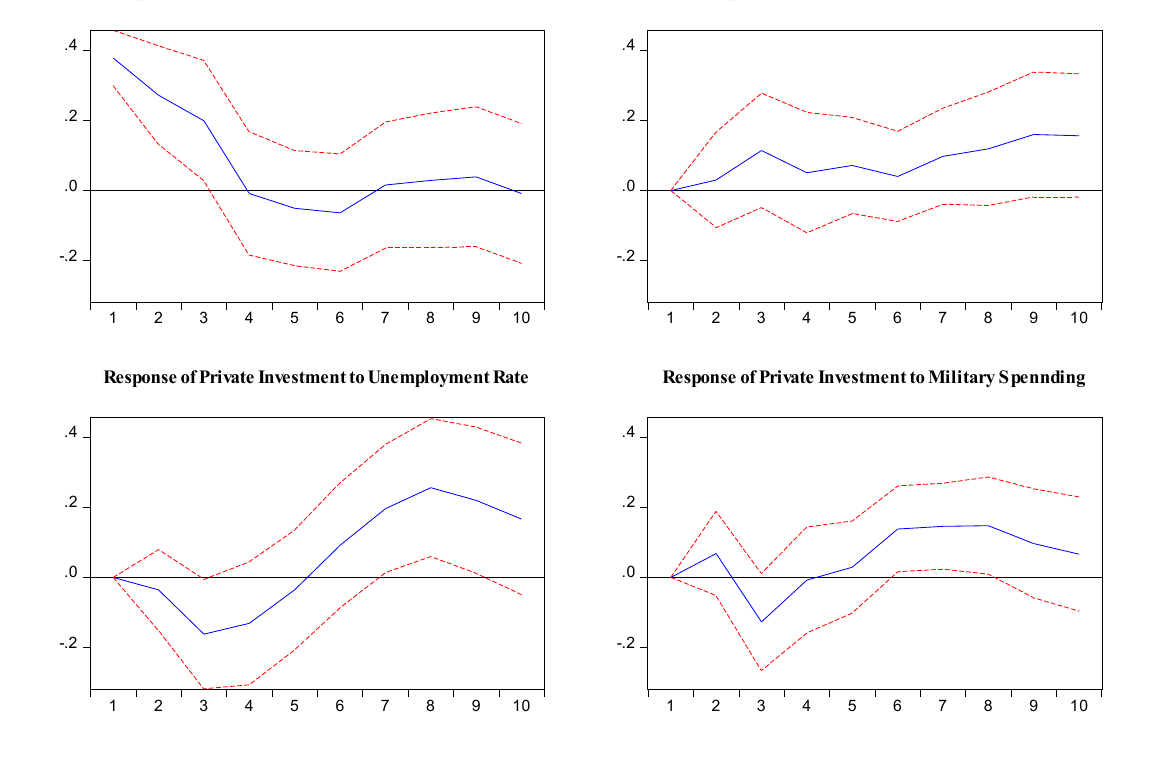
Table 8. Forecast error variance